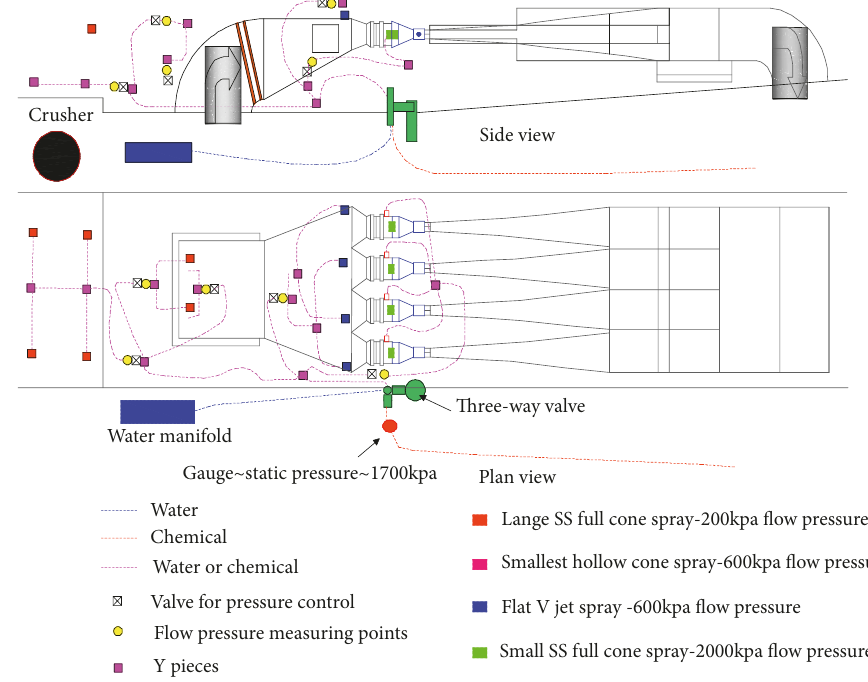
Figure 7: H 2 S scrubber spray